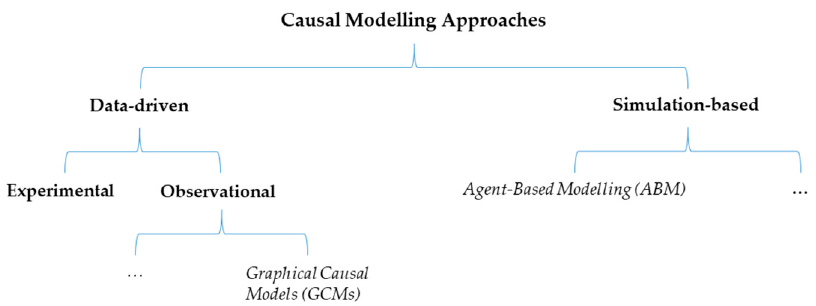
Figure 1. An illustrated classification of causal analysis methodologies. The target methodologies in this paper are shown in italics .